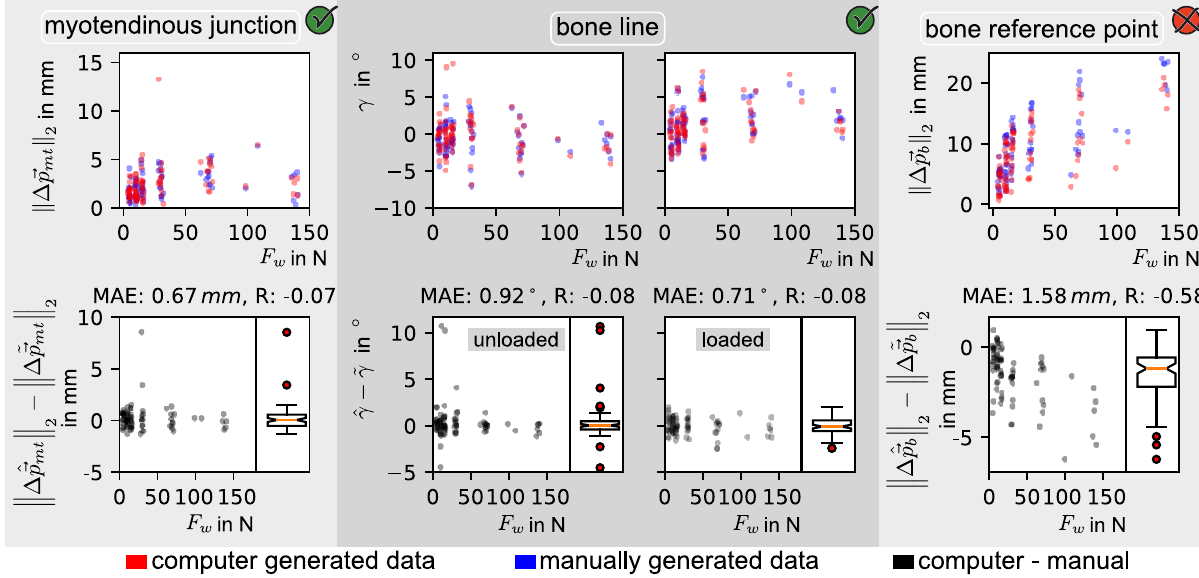
Fig 11. Comparison for each feature between manual and automatic data extraction. The green check mark in the upper right corner indicates that the corresponding method was used for evaluation in this work. The red cross indicates that the manually labeled data was preferred over the automatically extracted